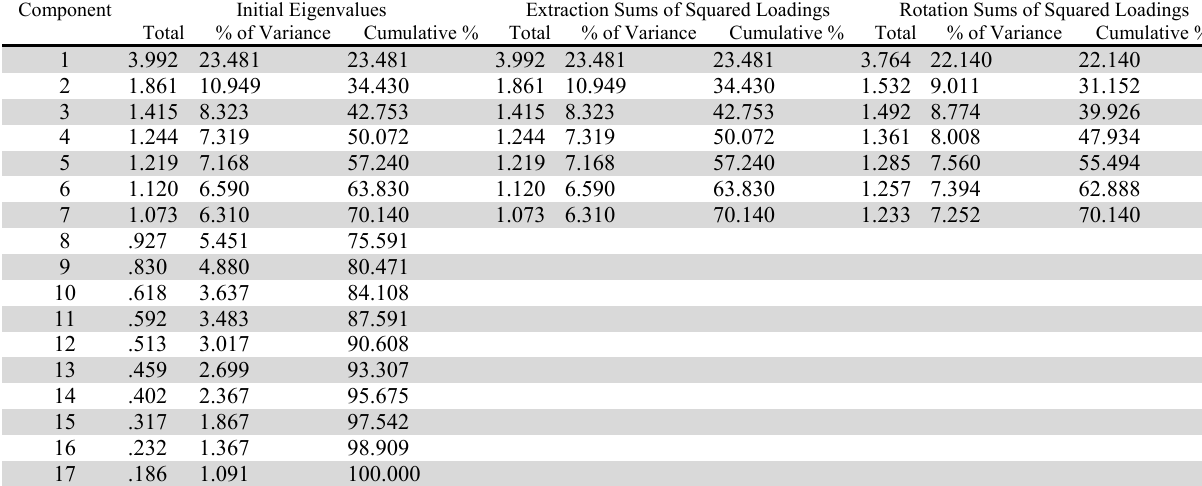
The summary of principal component analysis